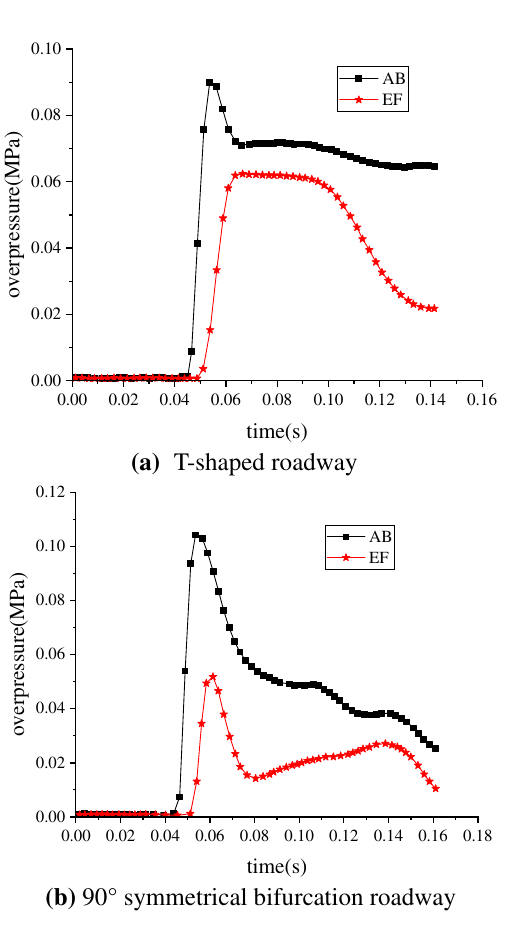
Fig. 11 Comparison of variation in gas overpressure with time for similar roadway